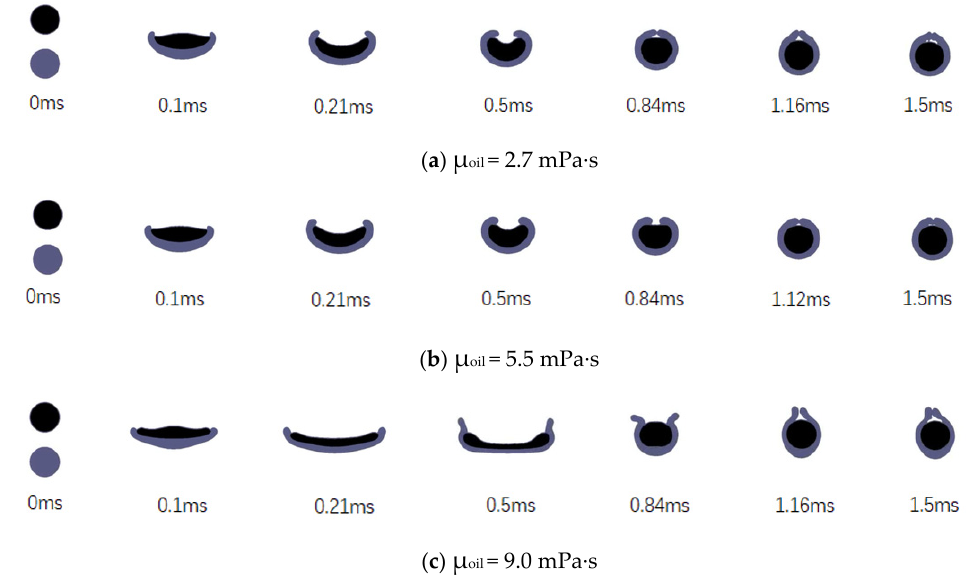
material properties are shown in Table 4.